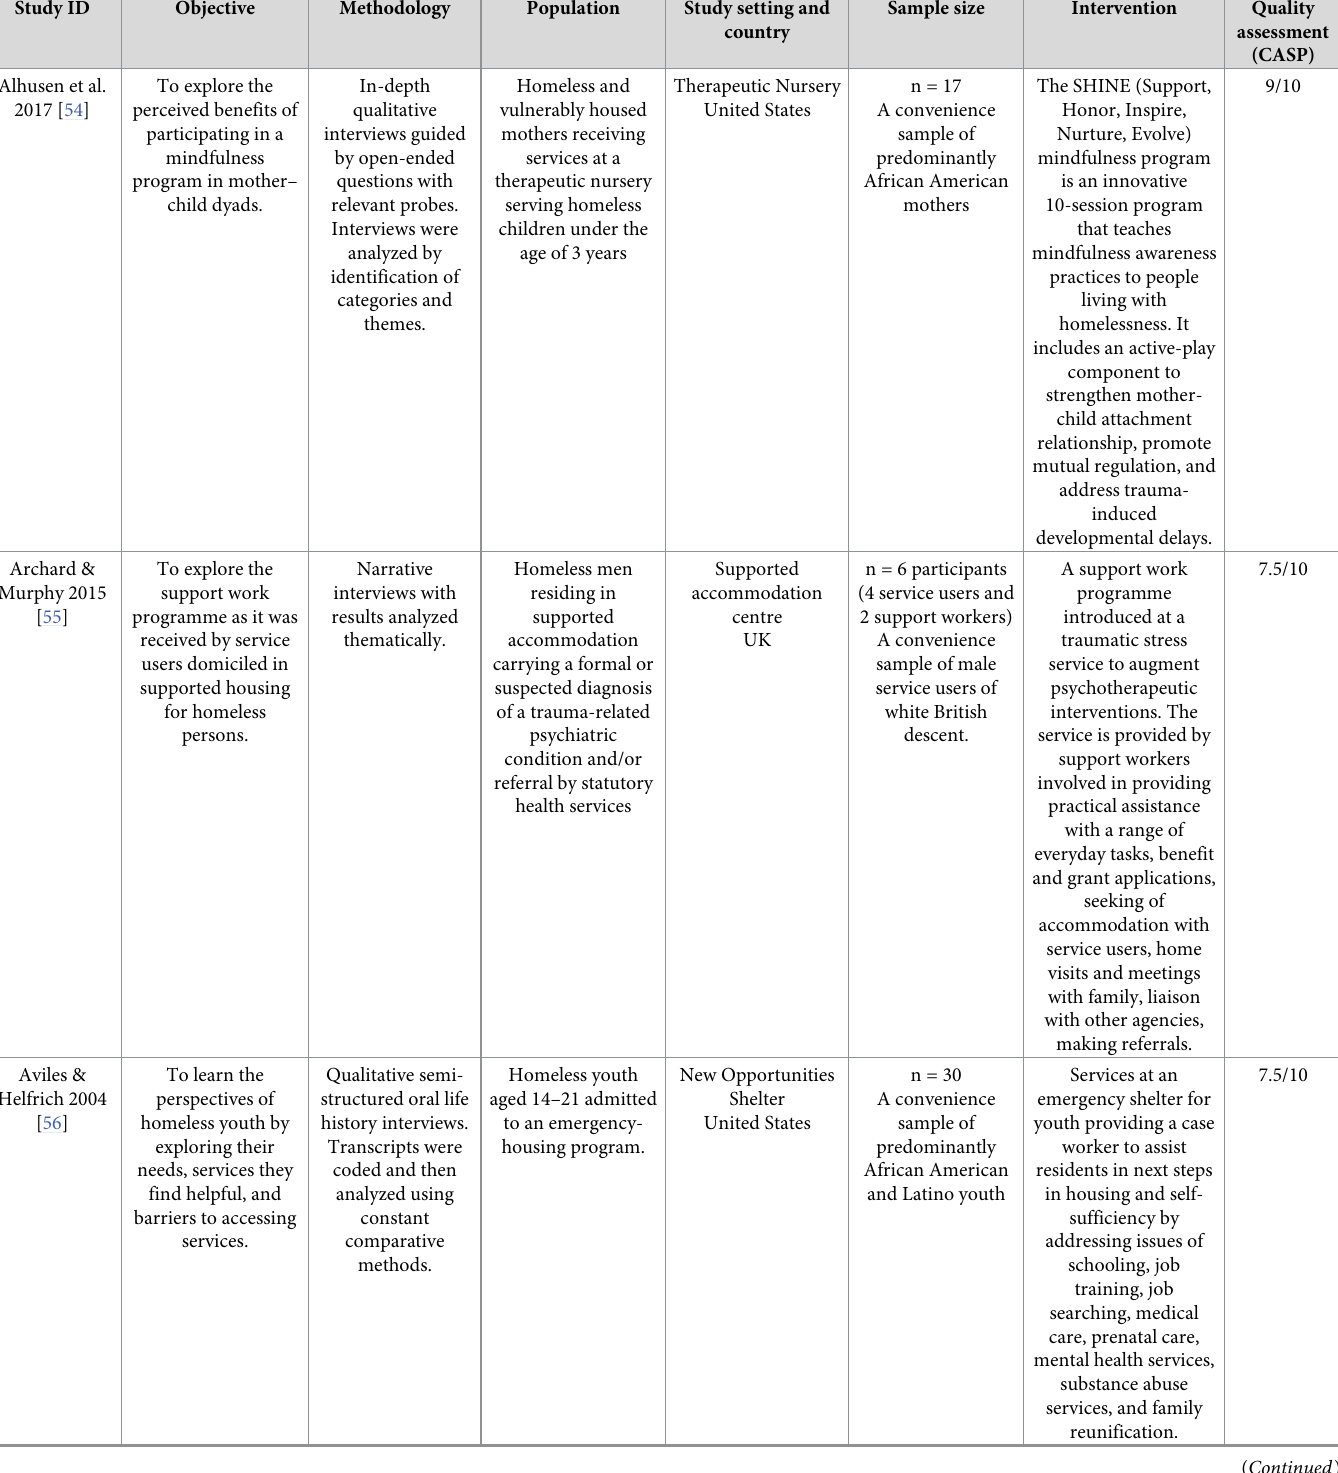
Table 3. Characteristics of included